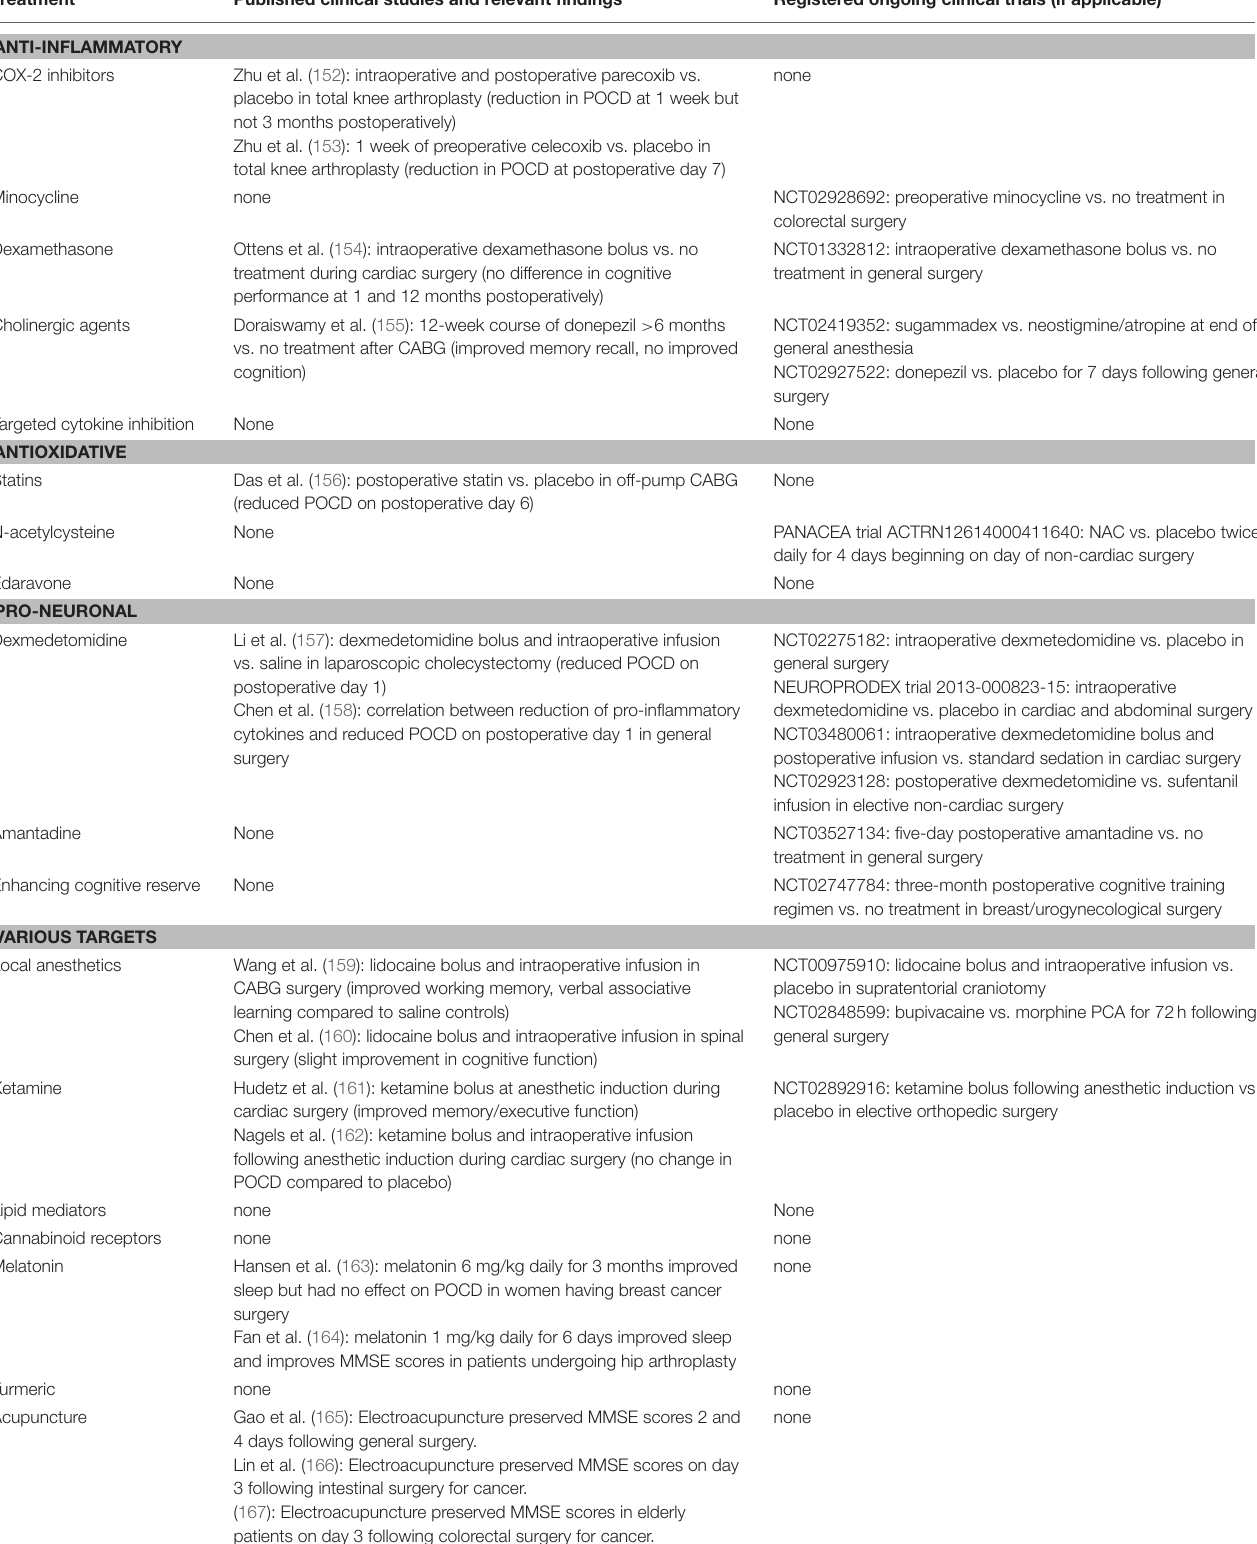
TABLE 3 | Clinical studies for proposed treatments for POCD. Treatment Published clinical studies and relevant findings Registered ongoing clinical trials (if applicable)